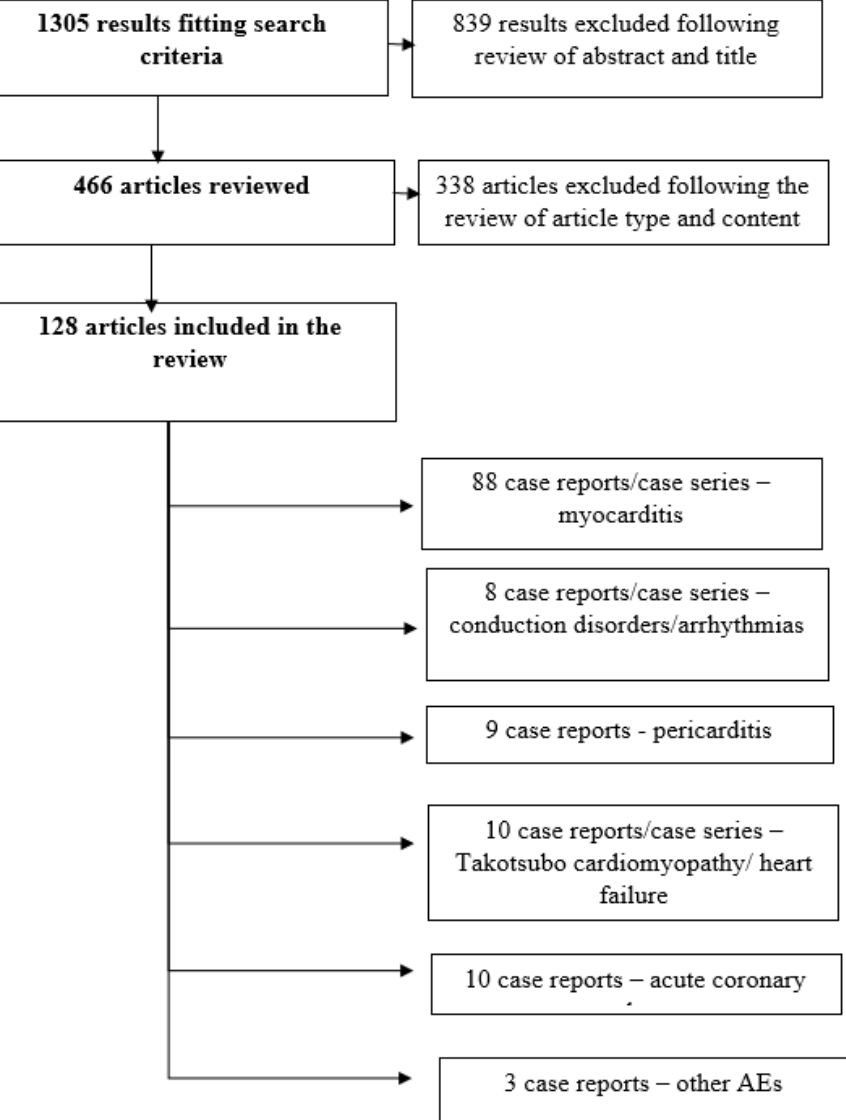
Figure 2. Flow diagram of the paper selection processes.